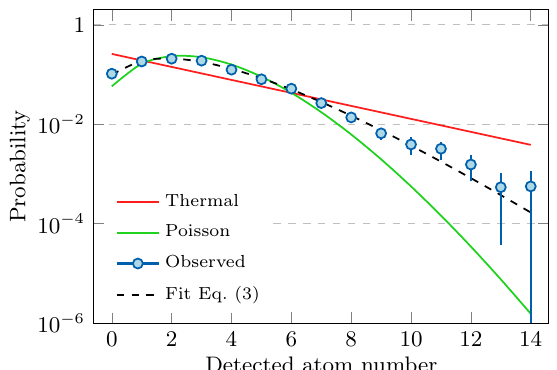
Figure 3: Counting statistics in a volume containing all 18 cells used in Fig. 2. The red line shows a thermal distribution with a mean detected atom number ( ην ) of 2.8, equal to that measured in the experiment. The green line shows a Poisson dis- tribution with the same mean. The dashed black line is the formula in Eq. (3), with M = 5.6. The error bars on the data points denote the statistical uncertainty (stan- dard deviation) estimated with the bootstrapping